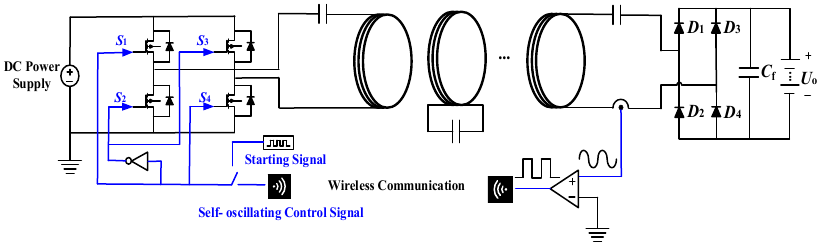
Figure 2. Self-oscillating control diagram for the domino WPT systems.